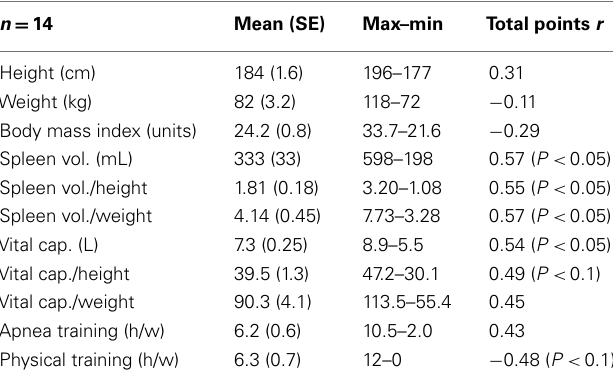
Table 1 | Correlation values of anthropometric- and training data to scored total